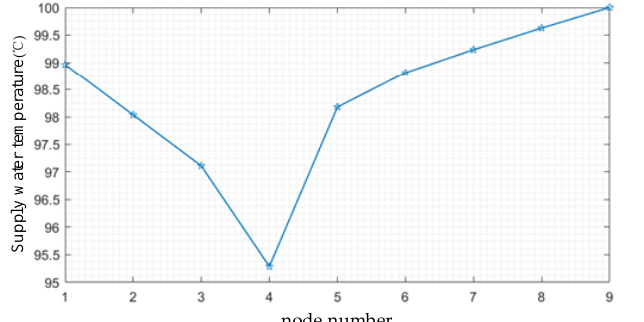
Figure 3. Pipeline flux of thermal power subsystem.